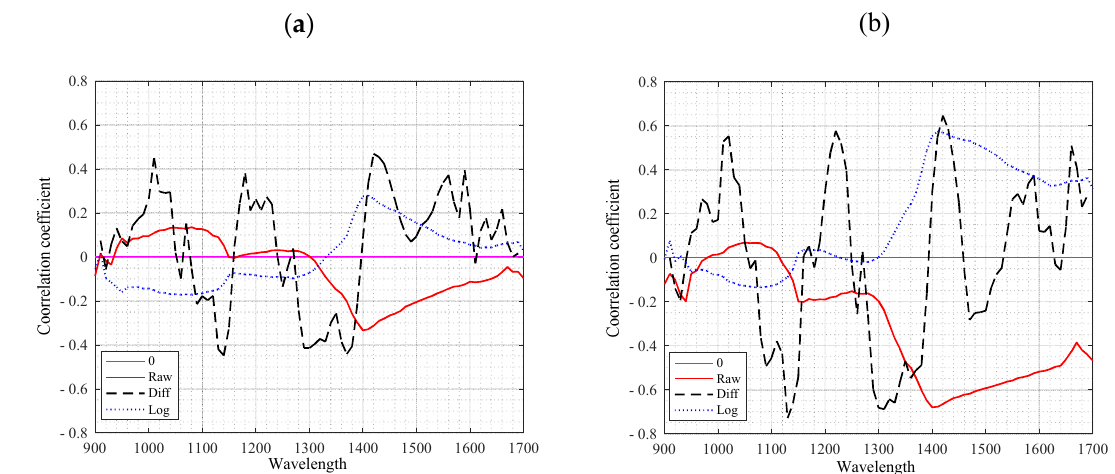
Figure 6. Correlation coefficient between the leaf water status and individual wavelength. ( a ) Leaf WC; ( b ) equivalent water thickness (g/dm 2 ). RAW: raw relative reflectance; DIFF: first derivative of relative reflectance; LOG: inverse-logarithm relative reflectance (1og(1/R)).